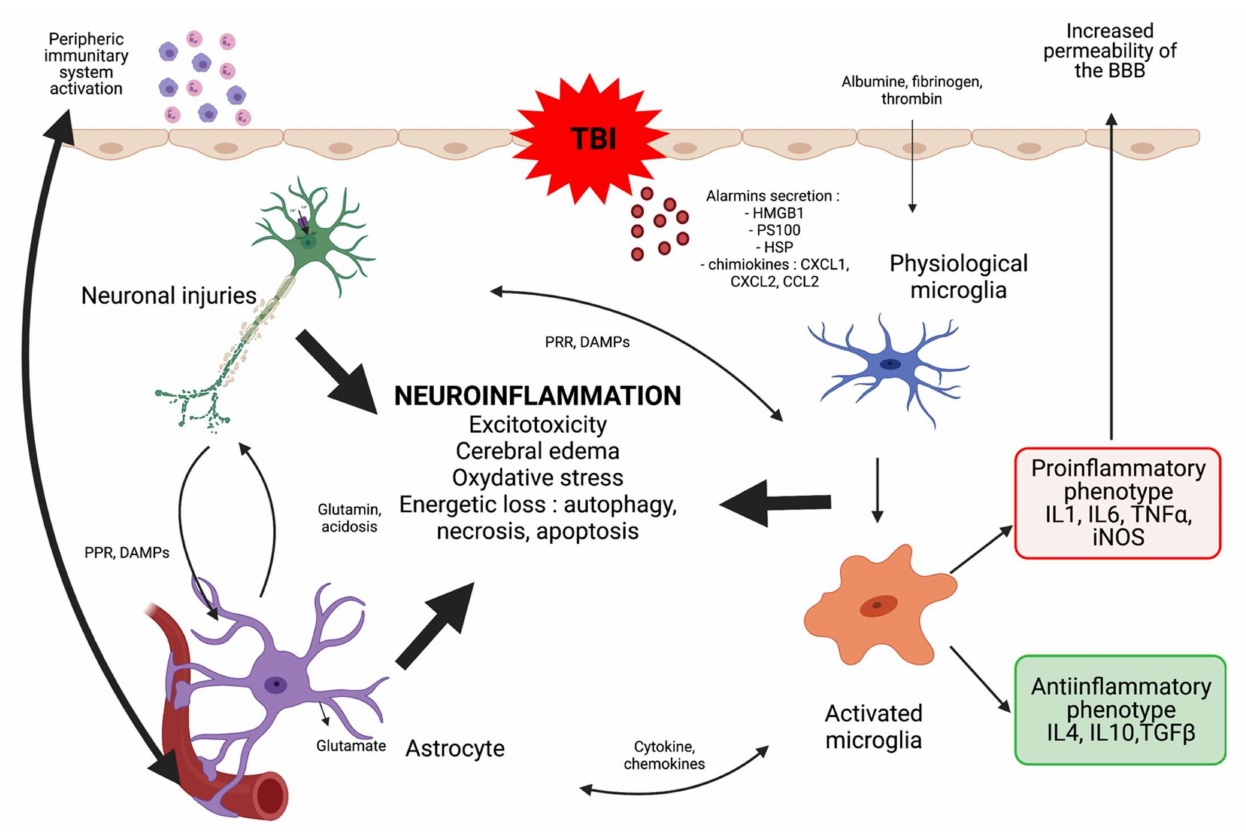
Figure 1. Schematic representation of post-traumatic neuroinflammation. The rupture of the blood- brain barrier, the release of alarmines (or DAMPS: Damage Associated Molecular Patterns) by injured cells and the production of cytokines are at the origin of an endothelial, astrocytic, and microglial activation with a change in conformation of the microglial cells which take an amoeboid conformation and migrate towards the injured area. This response to trauma is both localized and generalized with secondary recruitment of the peripheral immune system. BBB: blood brain barrier; CXCL: chemokine ligand; DAMPS: damaged associated molecular patterns; IL: interleukin; HMGB1: high mobility group bow 1; iNOS: inducible nitric oxide synthase; PRR: pattern recognition receptor; PS100: protein S 100; TBI: traumatic brain injury; TGF: transforming growth factor; TNF: tumor necrosis